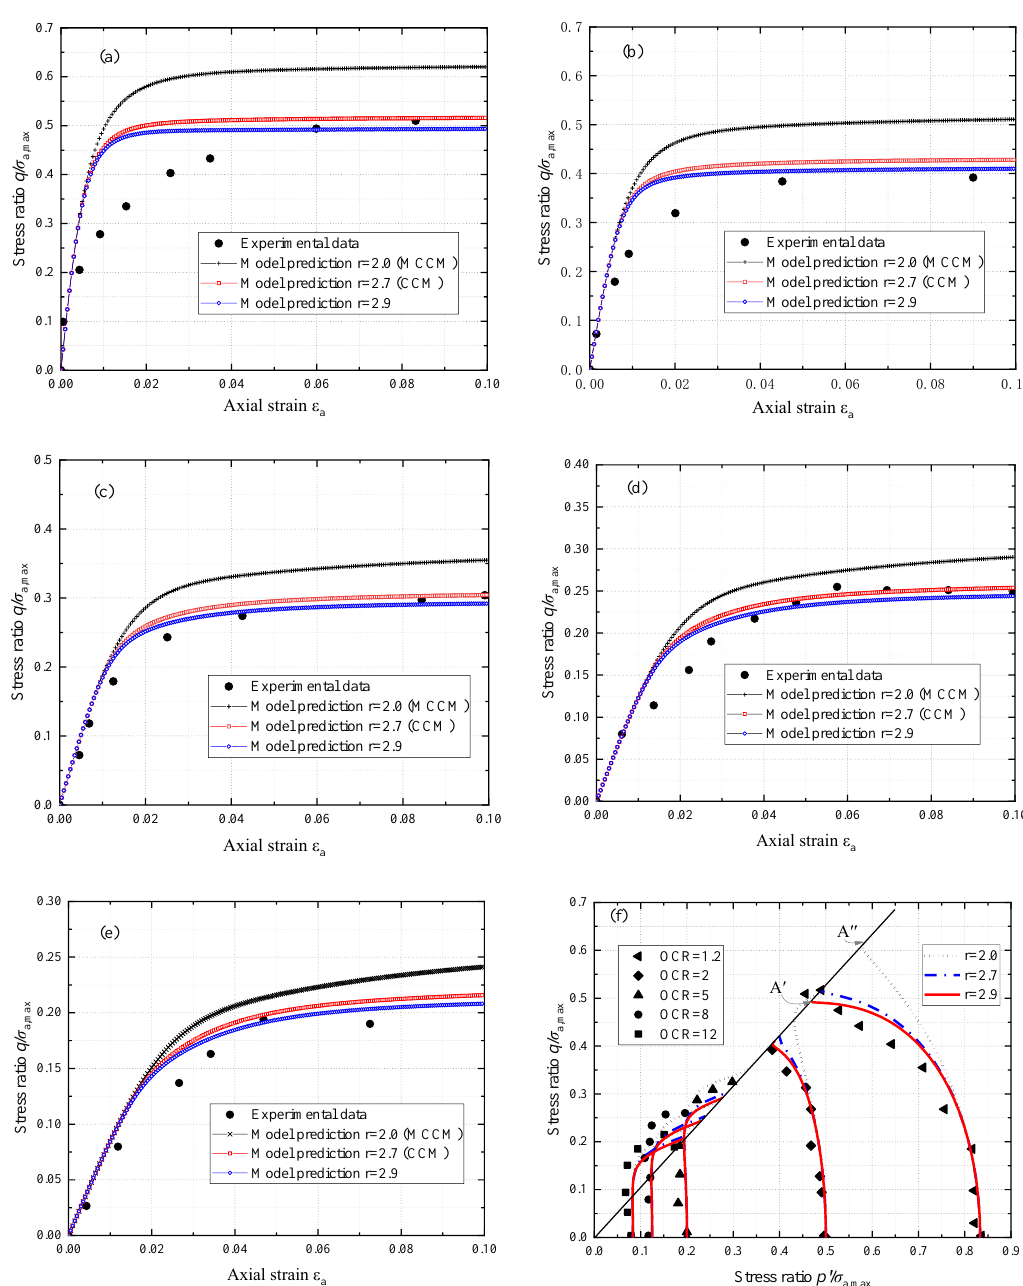
Figure 10. Comparisons between model prediction and test results ( a ) OCR = 1.2, ( b ) OCR = 2, ( c ) OCR = 5, ( d ) OCR = 8, ( e ) OCR = 12, ( f ) stress paths corresponding to different OCR.